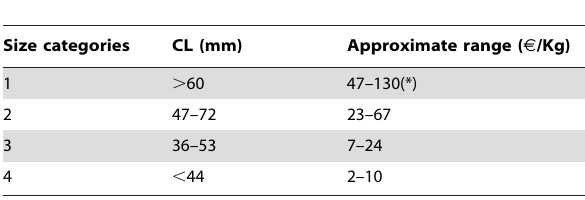
Table 3. Approximate price and corresponding size ranges for Nephrops .